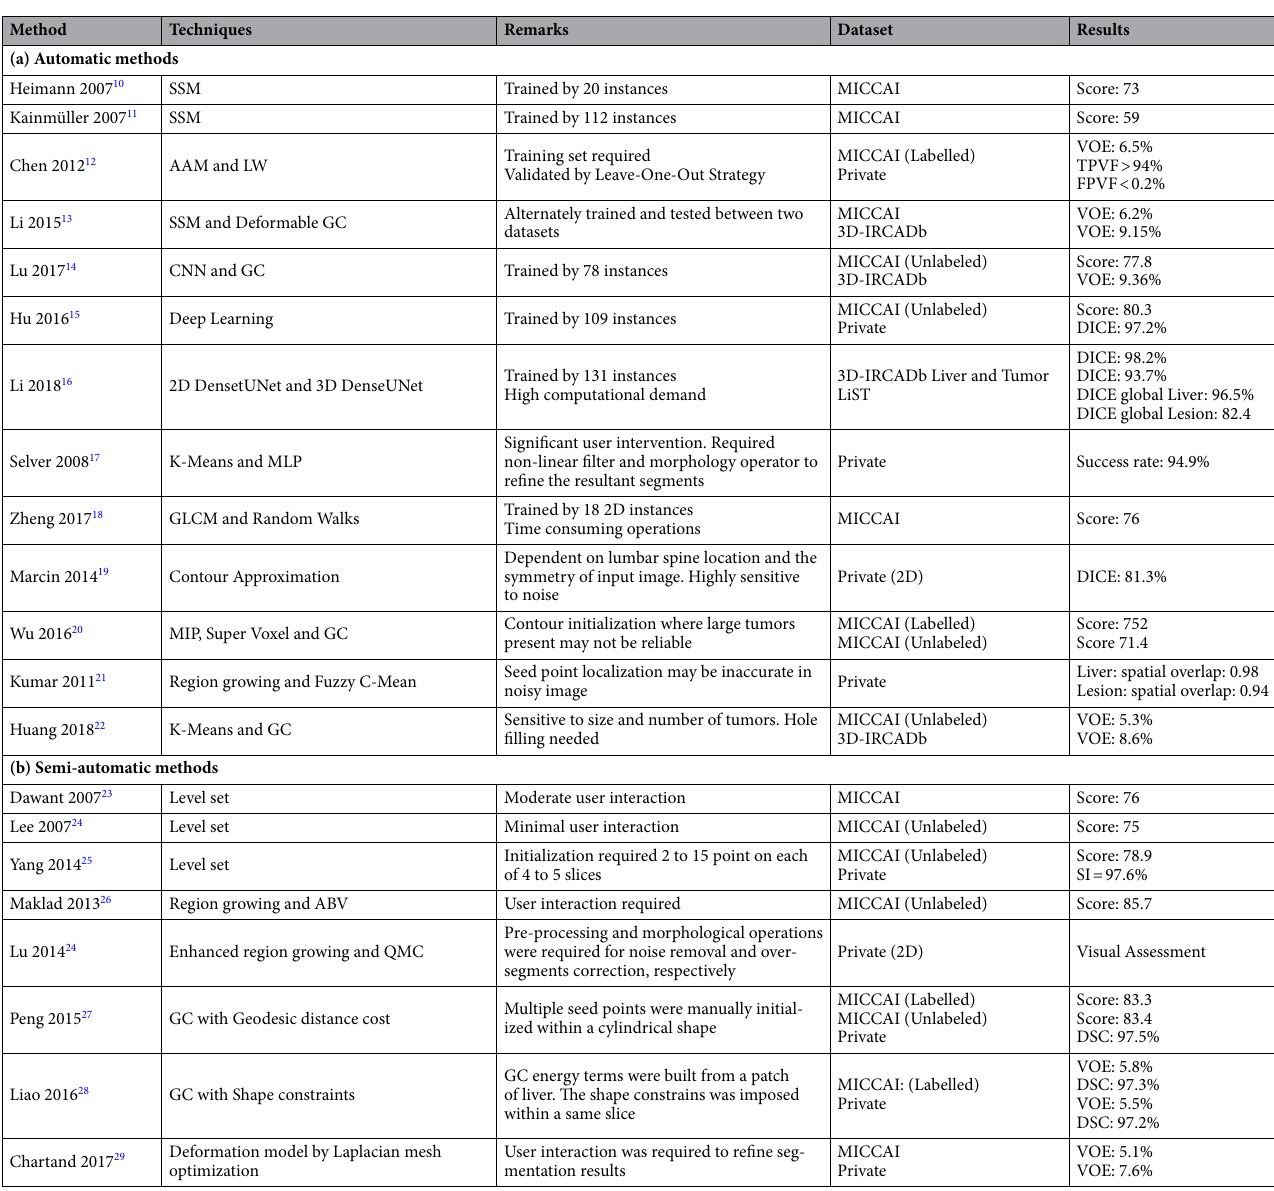
Table 1. Characteristics of early works on automatic methods (a) and semi-automatic methods